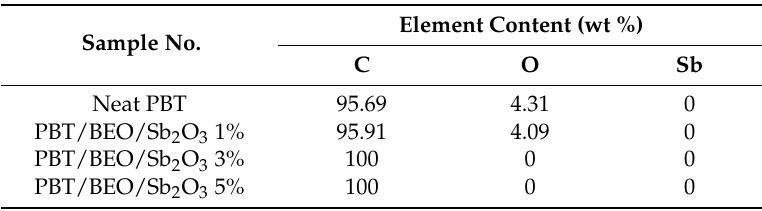
Table 6. Energy dispersive x-ray (EDX) data of the residues for the neat PBT and its composites after the cone calorimeter tests.